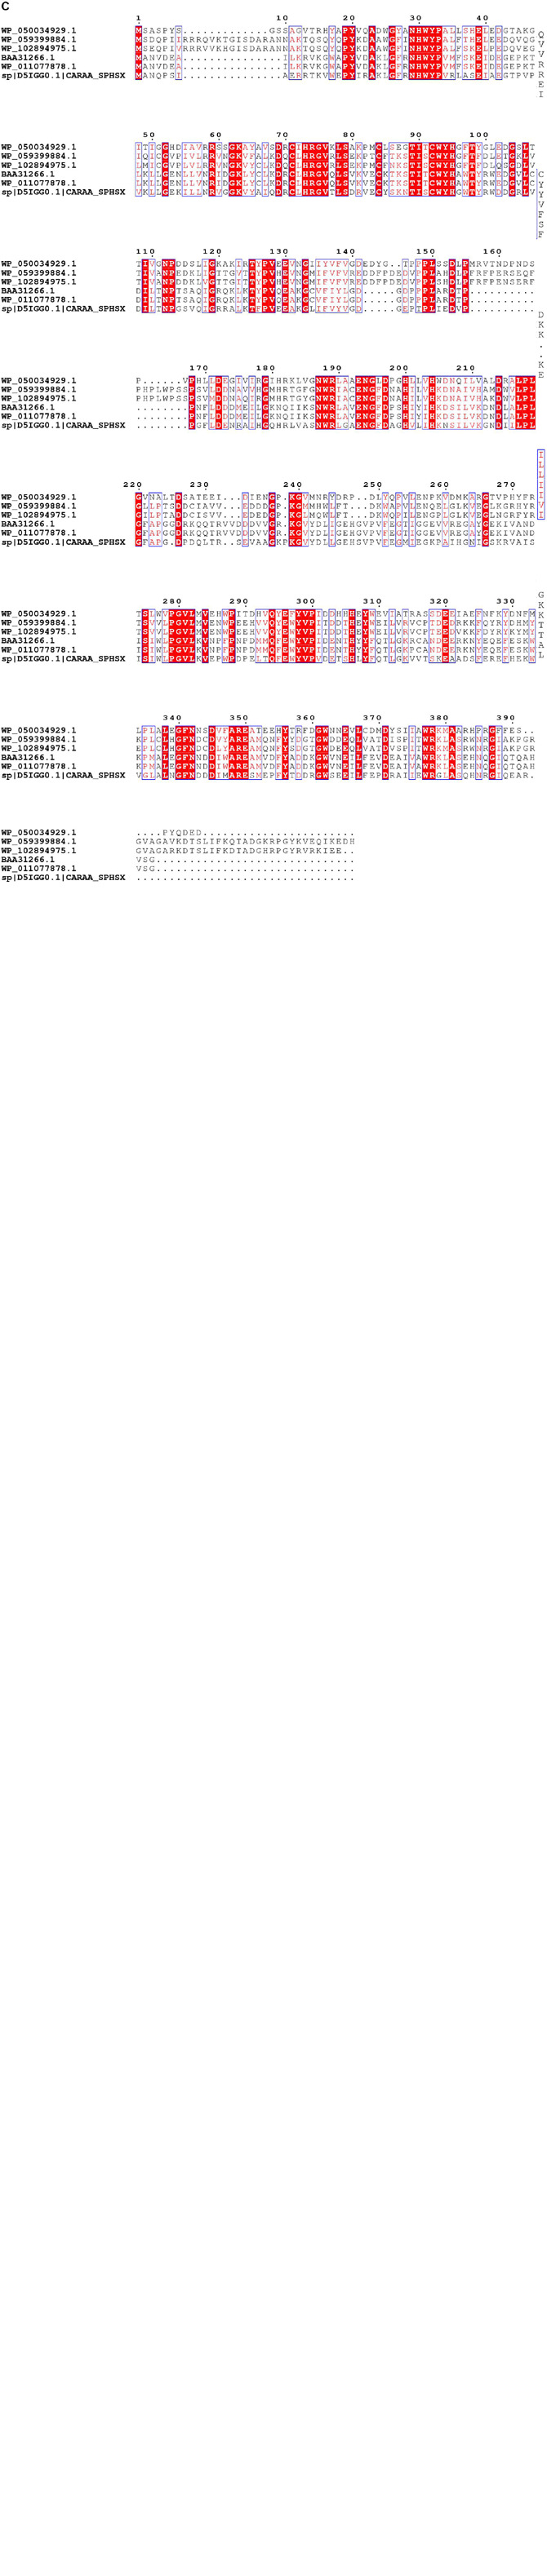
Sequence alignment of 1892 (A), 1893 (B) and 1894 (C), and their homologs from Pseudomonas, Mycobacterium sp., Mycobacterium vanbaalenii, Rhodococcus sp., Rhodococcus jostii, Sphingomonas sp., etc. Sequence alignment was performed using the ClustalW (v. 2.0) and ESPript programs. Conserved sequences are indicated by boxes, and similar sequences are indicated by colored background.